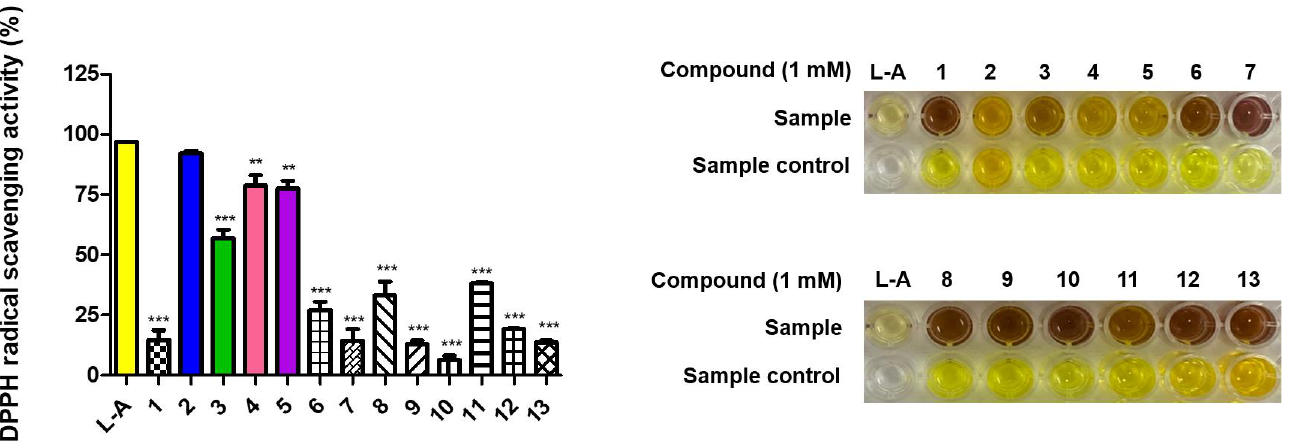
Figure 11. DPPH radical scavenging activities of the 13 ( Z )-BPTT analogs. Radical scavenging activities of ( Z )-BPTT analogs were investigated at a concentration of 1 mM after 30 min of treatment in the dark using L-ascorbic acid as a positive control. DMSO was used as a solvent for ( Z )-BPTT analogs and distilled water for L -ascorbic acid. L -A represents L -ascorbic acid. Asterisks indicate significant differences between L -ascorbic acid and ( Z )-BPTT analogs. Results shown are the means ± standard errors of 3 different experiments. ** p <0.01, *** p < 0.001.